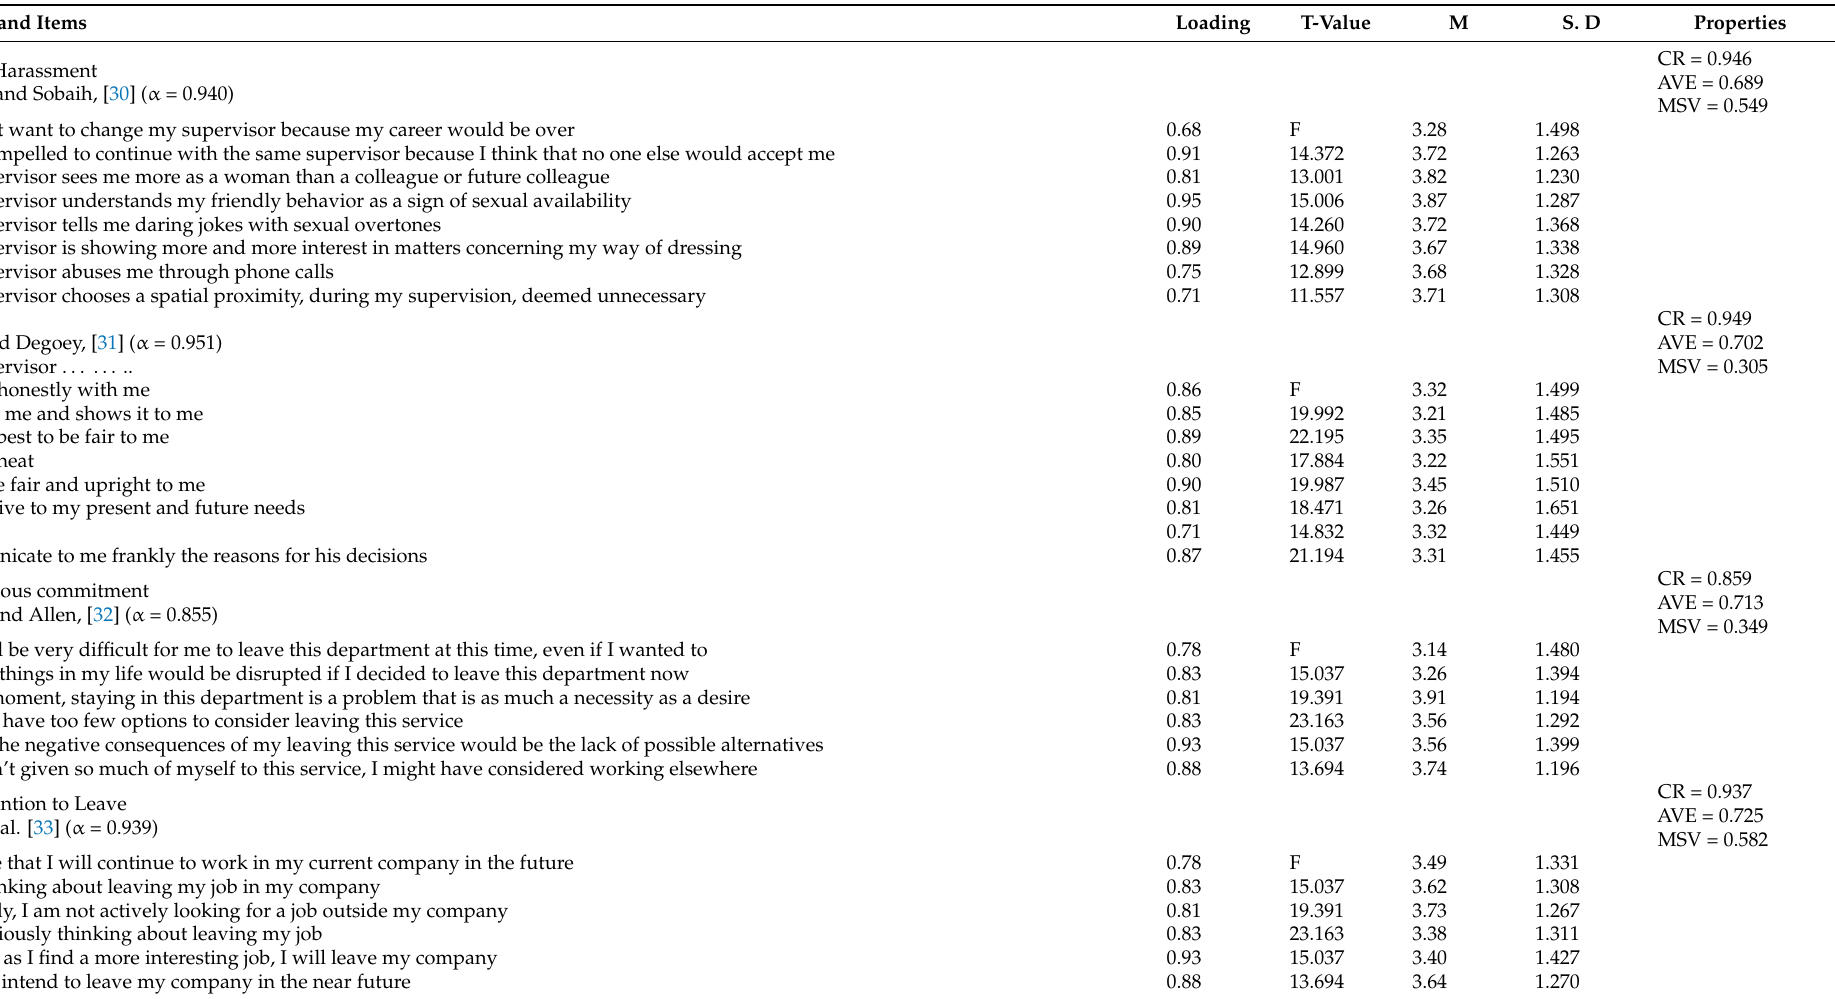
Table 2. Descriptive results of first order confirmatory factor